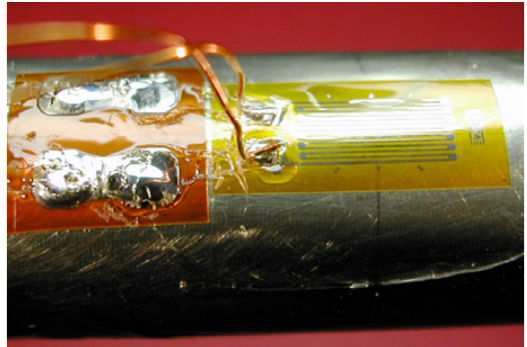
Fig. 2. Thin wires soldered to the strain gage’s tab.